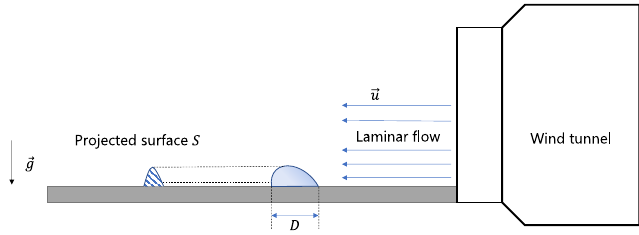
Fig. 4. Schematic view of the experiment to dislodge a horizontal drop with drag force. We use a wind tunnel, to ensure that the air fl ow is laminar and to shrink wind speed variability. The wind could blow from 1 to 30 ms (cid:2)